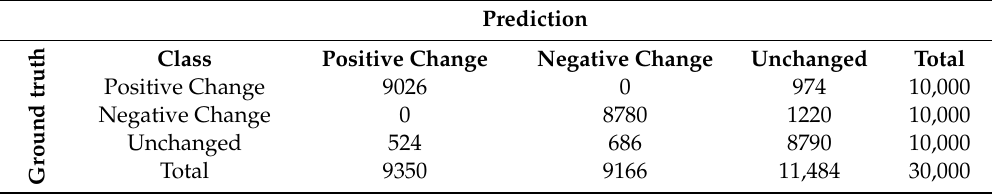
Table 6. Confusion matrix of the detection results of the proposed method in Nanjing